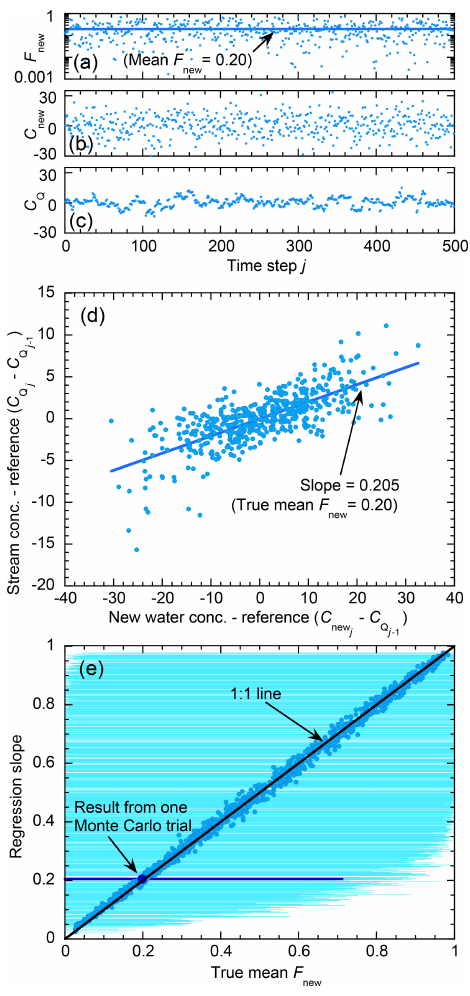
Figure A1. Benchmark test of regression estimates of mean new water fractions, using data from a simple two-component mixing model. In that mixing model (Eq. A8), a randomly varying new wa- ter fraction F new (a) determines the relative proportions of new and old water ( C ne w and C Q , respectively) which are combined to j j − 1 (c) . Among the 500-point yield a mixture with concentration C Q j time series shown in (a–c) , the new water fraction F new varies be- tween 0.0001 and 0.71, with a mean of 0.20 and a standard devia- tion of 0.15. Plotting the concentration of the mixture in the stream as a function of the concentration in the new water end-member (e) yields a regression slope of 0 . 205 ± 0 . 009, which agrees within error with the true average of F new of µ = 0 . 20. Repeating this anal- ysis 1000 times, with mean values of F new ranging from nearly zero to nearly one, yields regression slopes that agree with the means of the F new for each Monte Carlo trial with an RMSE of only 0.02 (e) . In (e) , the circles show the regression slopes and mean F new , and the horizontal light blue lines show the range of F new , for each Monte Carlo trial. The dark circle and dark line show the results for the individual Monte Carlo trial shown in (a–d)